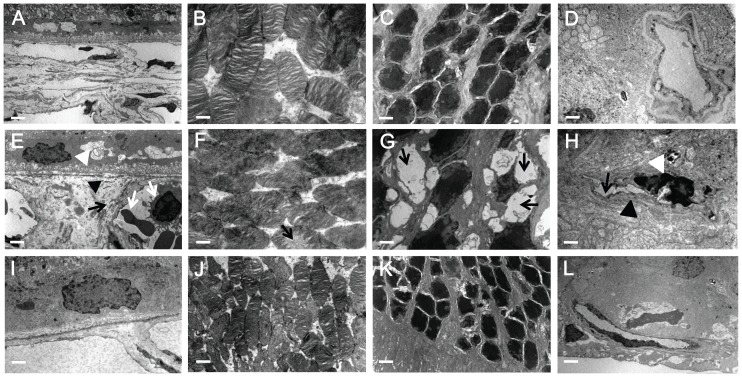
α-MSH ameliorated ultrastructural changes in the early diabetic retina.TEM images of the normal retina (A–D), the diabetic retina (E–H), and the diabetic retina with α-MSH intervention (I–L) are shown. In the diabetic retina (E–H), collagen fibers of the Bruch's membrane were broken and protruded to the capillary lumens (E, black arrow head), basement membranes of the choroid capillaries appeared thickened and laminated (E, black arrow), and the capillary lumen was congested with blood cells (E, white arrows). Bubbles (F, black arrow) and medullary scale bodies (G, black arrows) were observed in the photoreceptor outer segments and outer nuclear layer, respectively. The lumen of the inner retina capillary was severely congested (H, black arrow) by the deformed red blood cells (H, white arrow head), and the basement membrane appeared swelled (H, black arrow head). The ultrastructures of the α-MSH-treated diabetic retinas were greatly improved (J–M) and similar to those in the normal controls (A–D), n = 5/group. Scale bar, 500 nm.